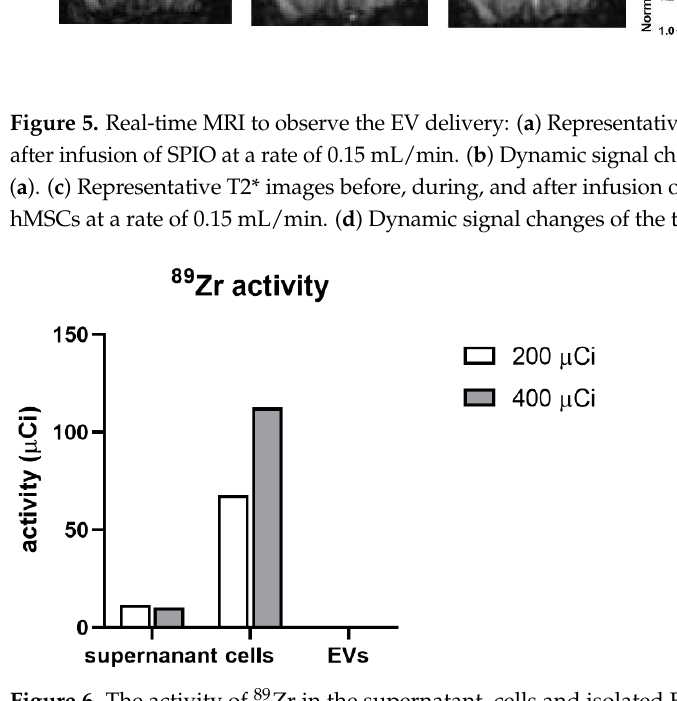
Figure 5. Real-time MRI to observe the EV delivery: ( a ) Representative T2* images before, during, and after infusion of SPIO at a rate of 0.15 mL/min. ( b ) Dynamic signal changes of the two ROIs marked in ( a ). ( c ) Representative T2* images before, during, and after infusion of EVs from Molday ION-treated hMSCs at a rate of 0.15 mL/min. ( d ) Dynamic signal changes of the two ROIs marked in ( c ).